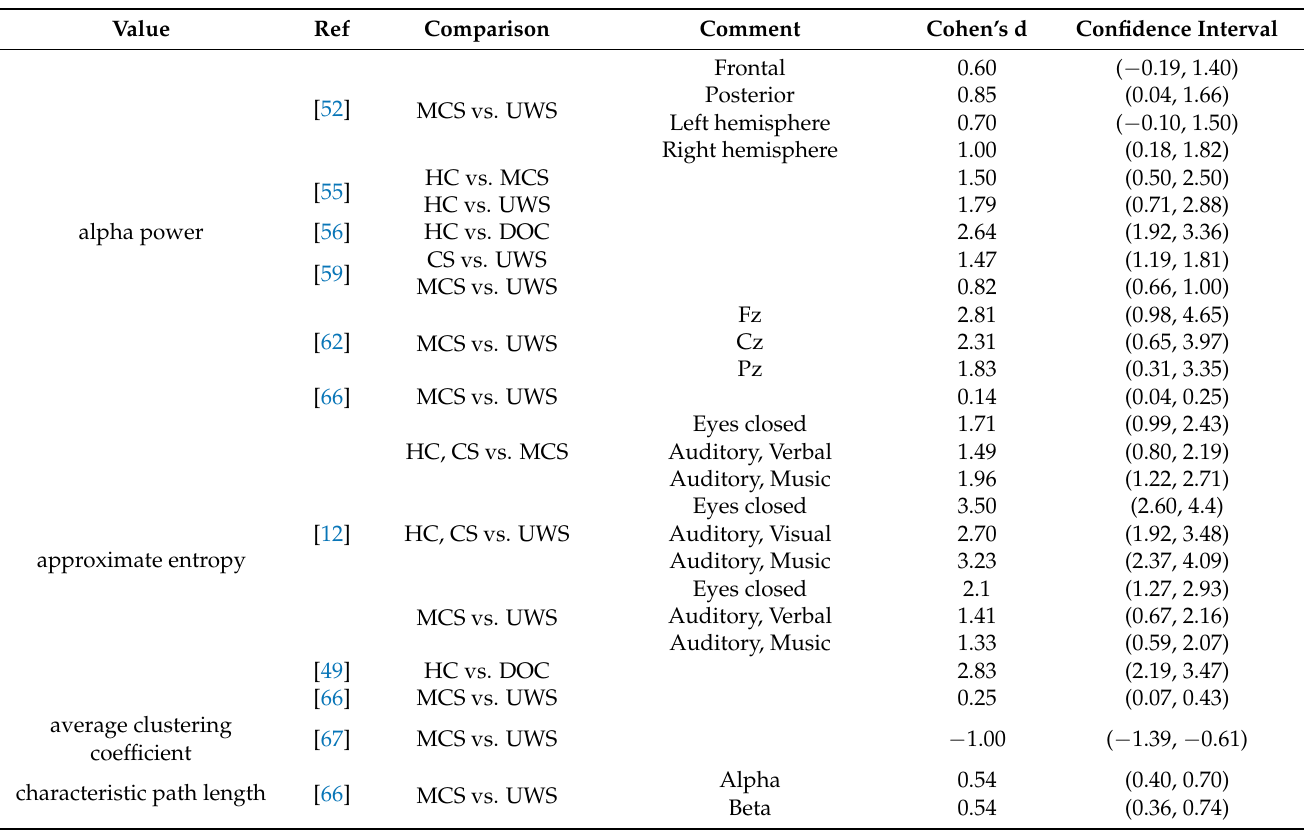
Table 7. Overview of different values and their correlation with consciousness; abbreviations can be found in Abbreviation. d is Cohen’s d and the values in parenthesis are the confidence intervals. Fz, Cz, Pz, Oz refer to the EEG electrodes’ location. Papers that do not present enough data to calculate Cohen’s d are not included in the